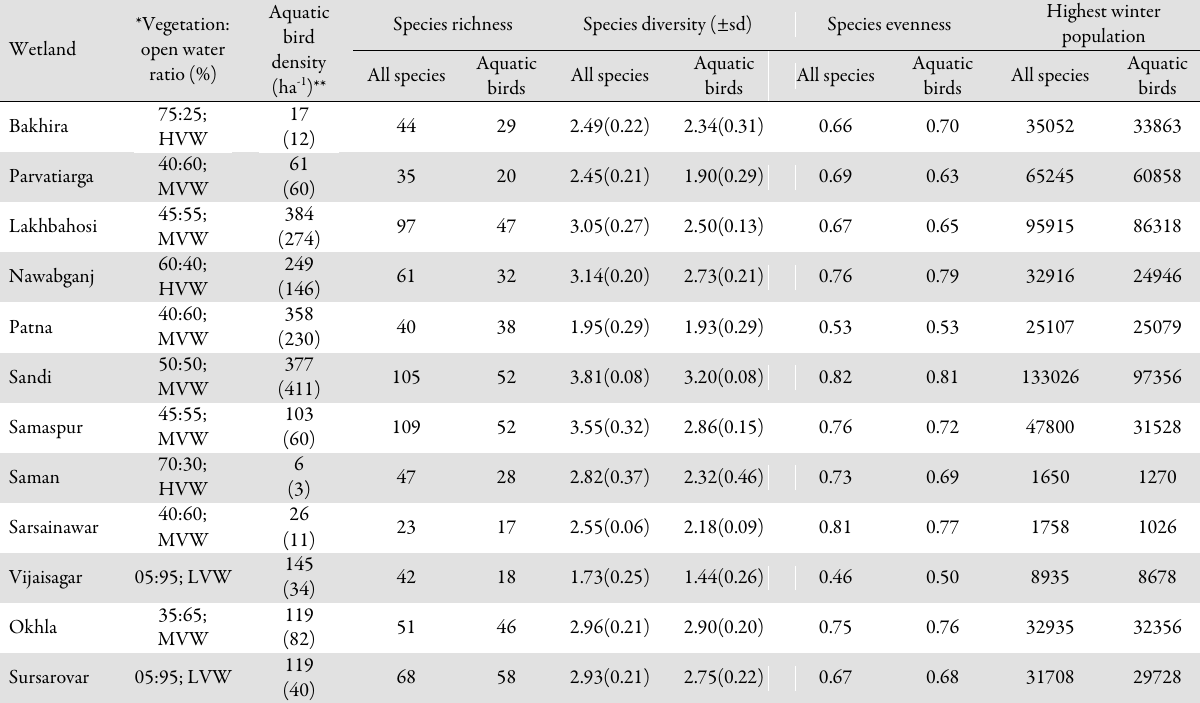
Table 3. Vegetation: open water ratio and avian population attributes of different wetlands